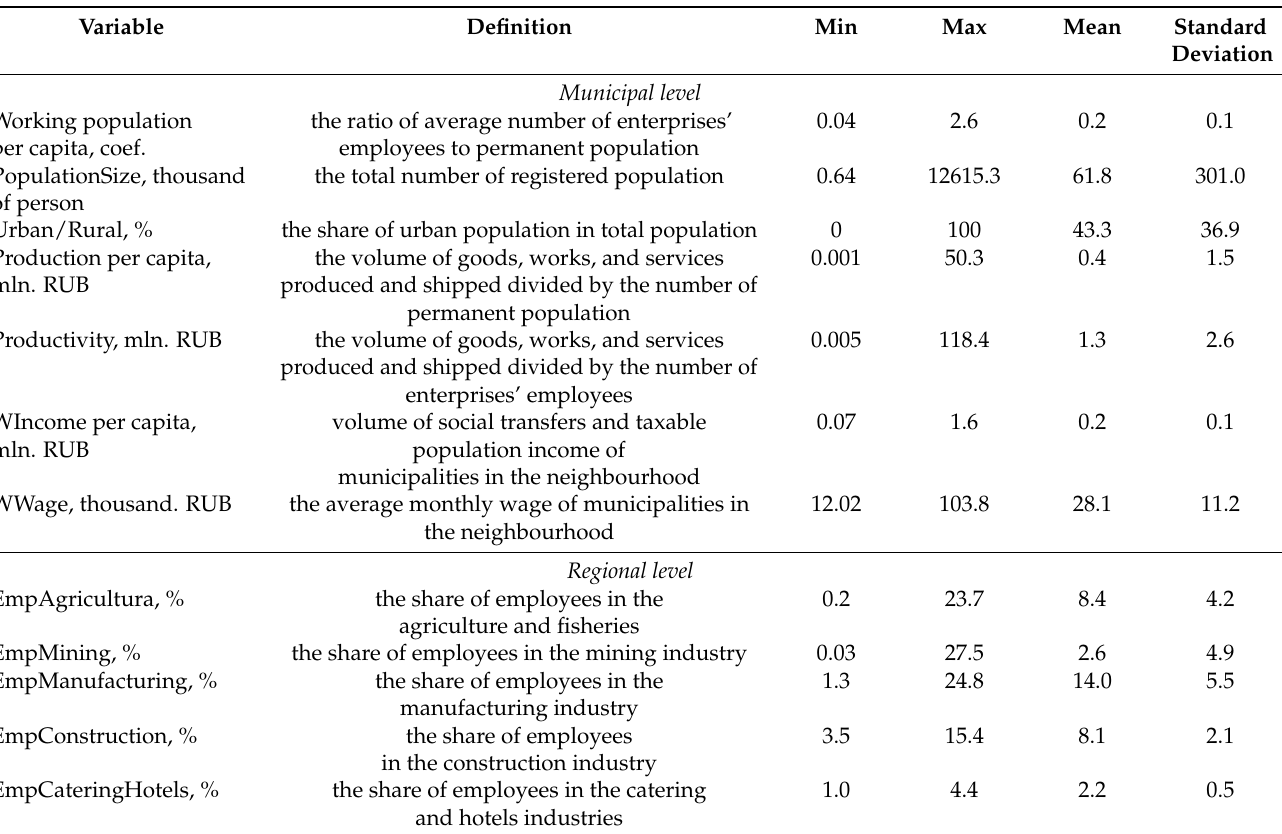
Table A1. Description of Independent